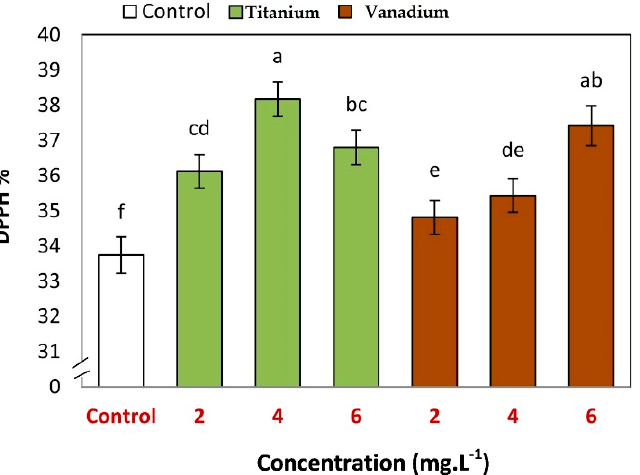
Figure 5. DPPH-scavenging activity of red cabbage leaves treated with different concentration of Ti and V. The mean values followed by a different letter are significantly different at p < 0.05 according to the Duncan test ( n = 3).